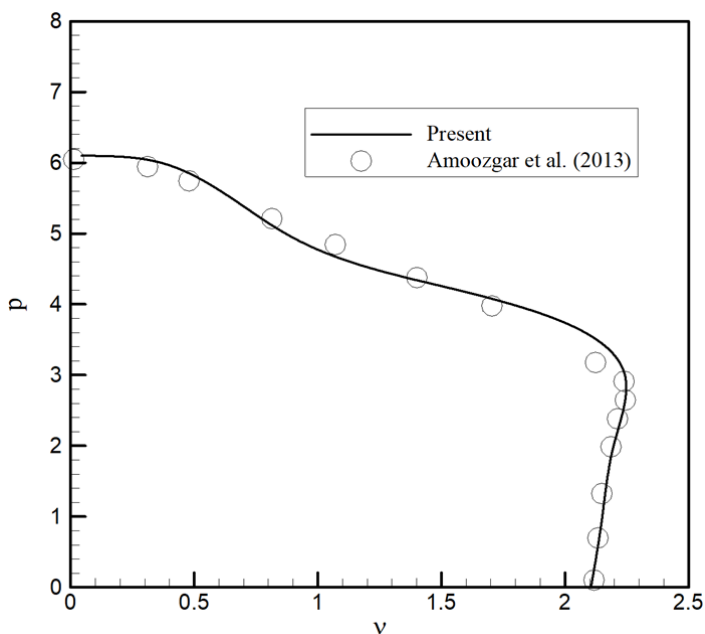
Figure 3. Comparison of the flutter speed of the wing with one engine for λ = 1. ν is the nondimen- sional flutter speed, and p is the nondimensional engine